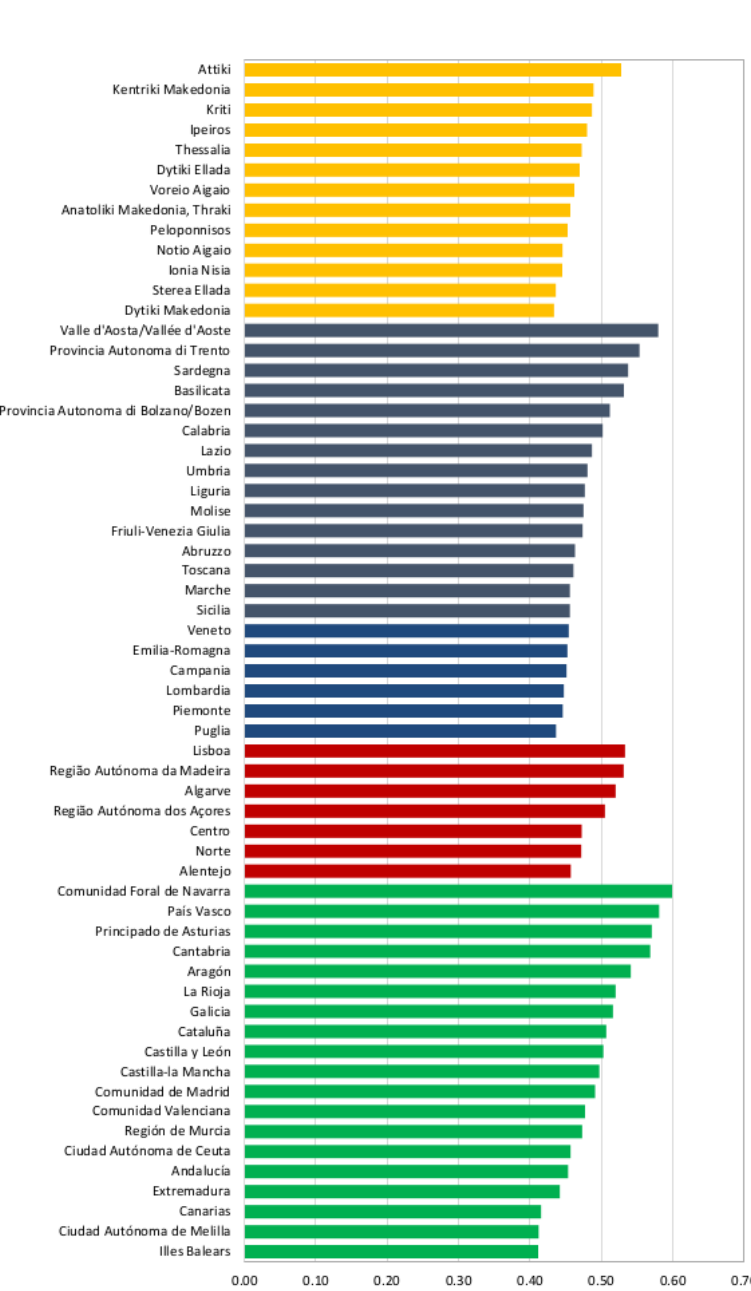
Figure A.2: The Social Indicator of the south European regions